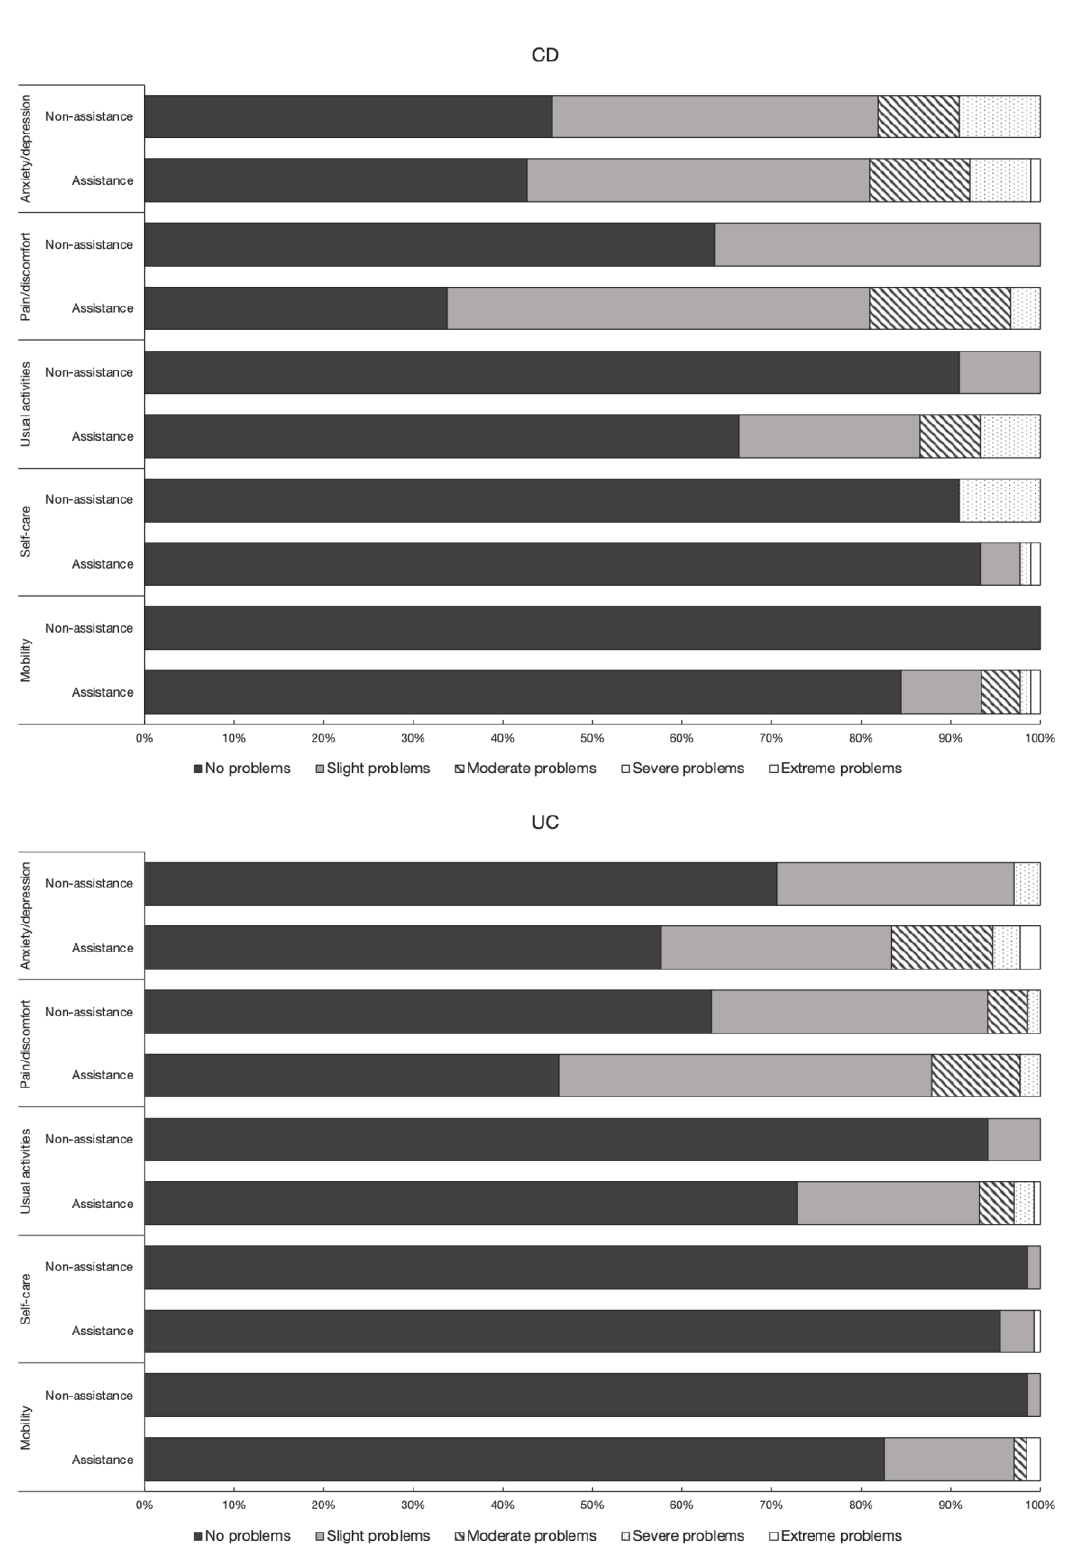
Figure 2. Distributions of responses on the five domains of the EQ-5D-5L. (EQ-5D-5L: five-dimension, five-level EuroQol instrument)